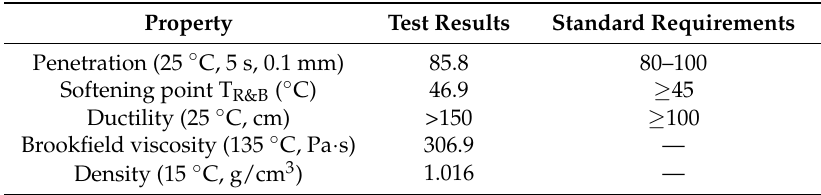
Table 1. Basic properties of matrix asphalt.